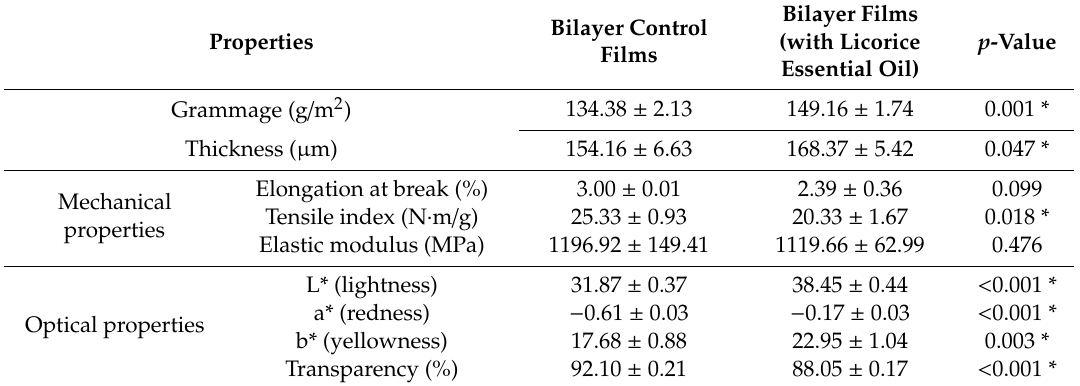
Table 1. Grammage, thickness, mechanical and optical properties of bilayer